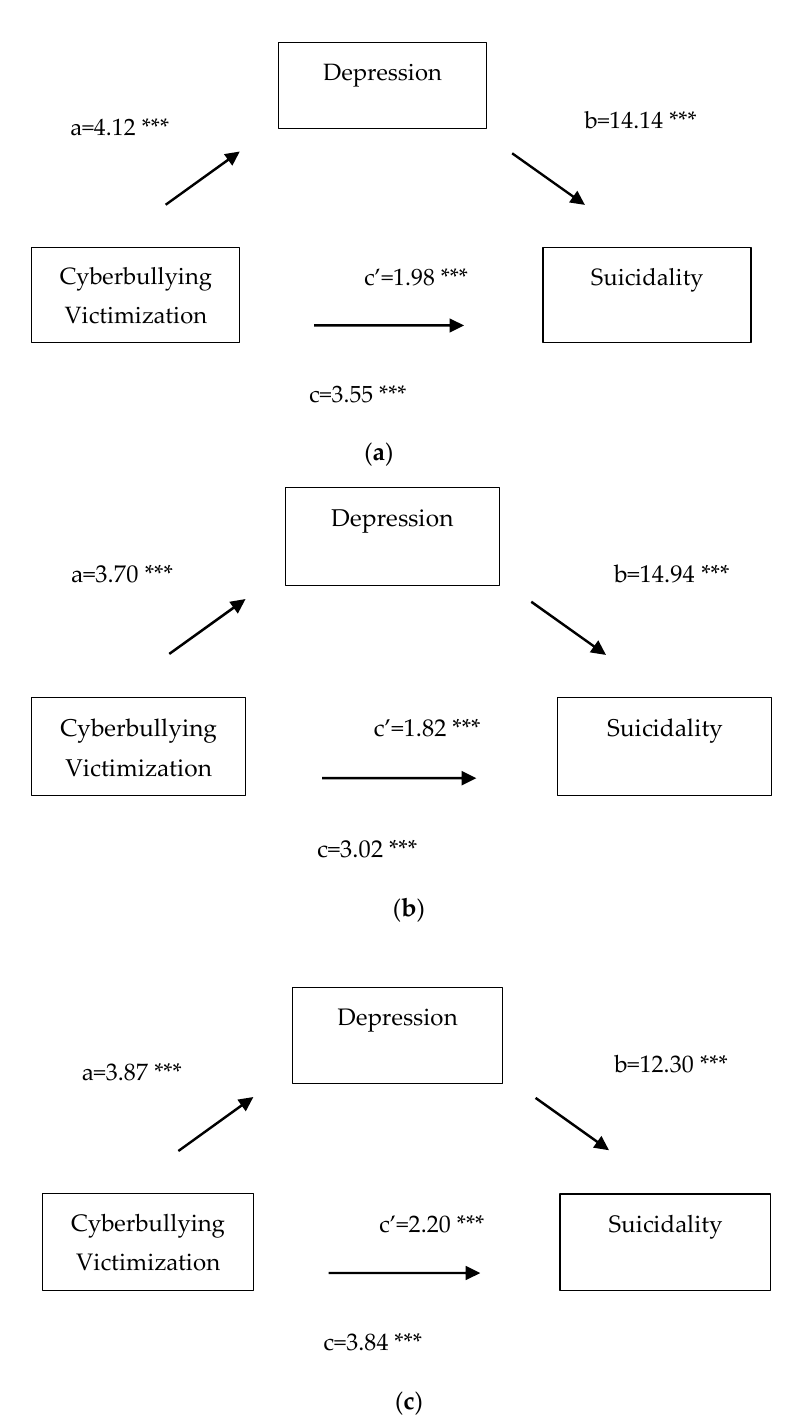
Figure 1. ( a ) Standardized regression coefficients for the relationship between cyberbullying victimization and suicidality as mediated by depression, among a representative sample of U.S. high school students ( n = 10,309) p < 0.001 ***. ( b ) Standardized regression coefficients for the relationship between cyberbullying victimization and suicidality as mediated by depression, among a representative sample of U.S. high school students, female subsample ( n = 5333). p < 0.001 ***. ( c ) Standardized regression coefficients for the relationship between cyberbullying victimization and suicidality as mediated by depression, among a representative sample of U.S. high school students, male subsample ( n = 4976) p < 0.001 ***.